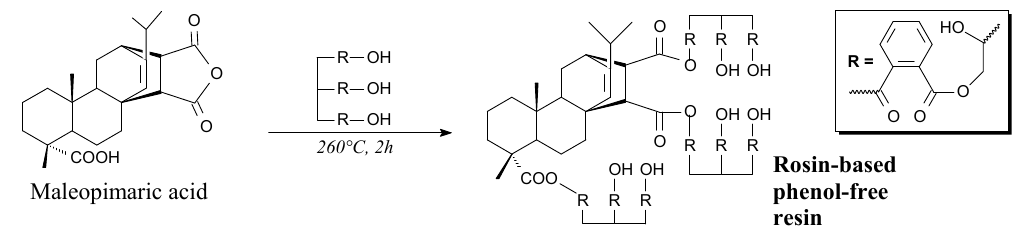
Scheme 79. Preparation of rosin-based phenol-free resin.